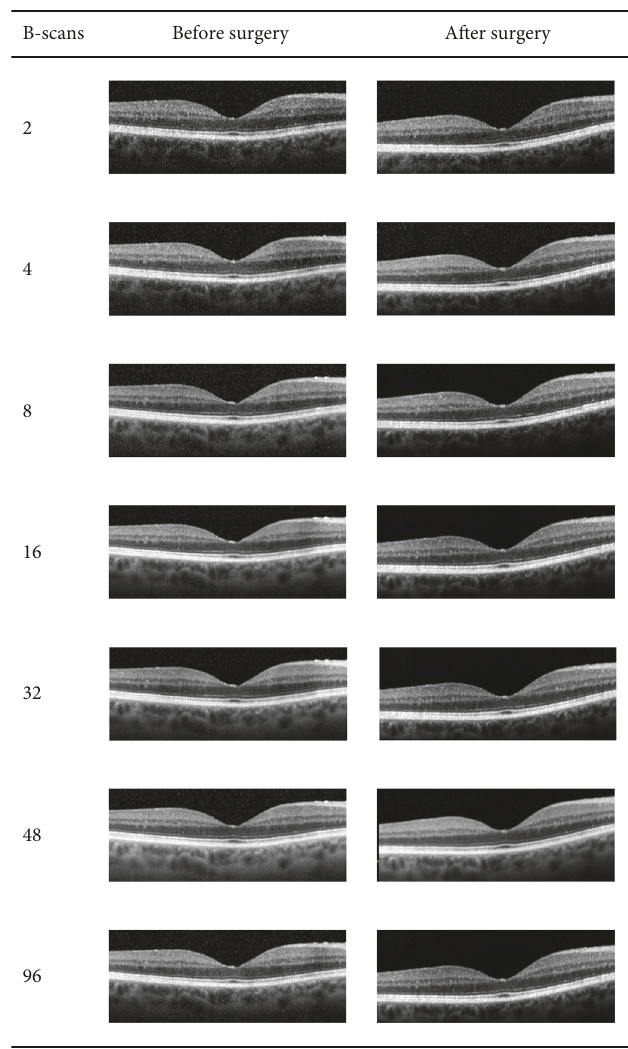
Figure 1: Exemplar OCT scans of a study patient acquired with di ff erent averaging settings. Left: number of B-scans averaged. Middle: images acquired before cataract surgery with turbid media. Right: images acquired after cataract